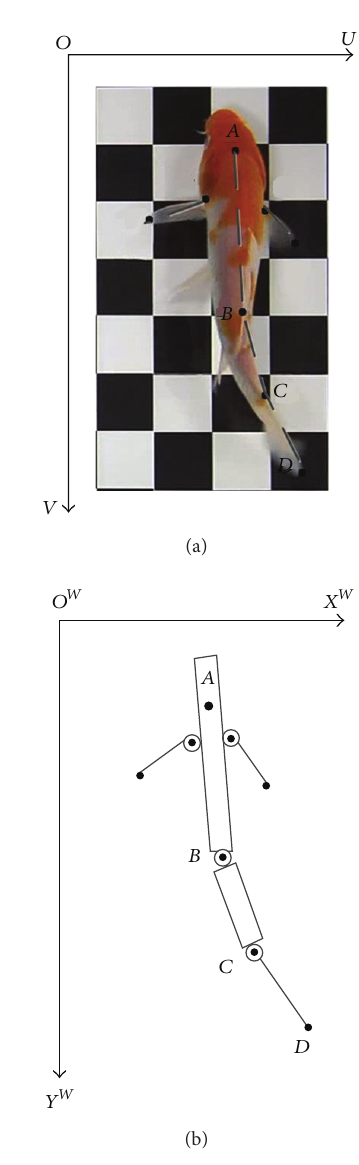
Figure 9: The Carp swimming image of eight feature points